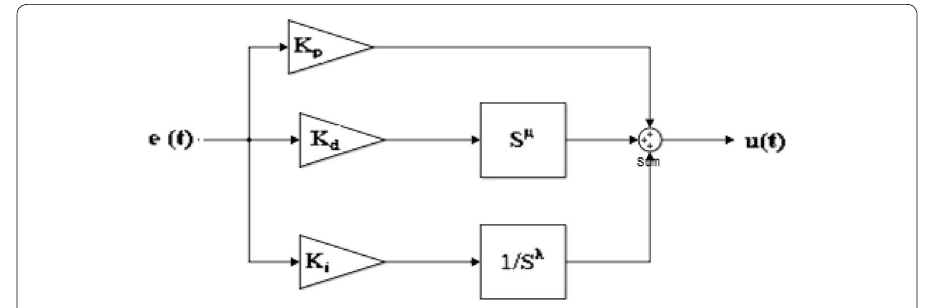
Fig. 2 Fractional-order PID controller